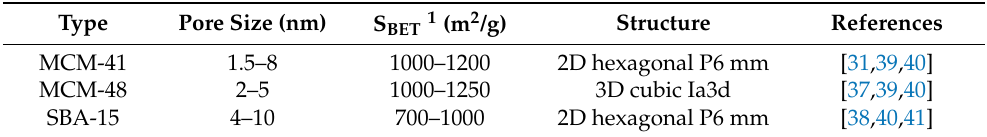
Table 1. Types of ordered mesoporous silica.